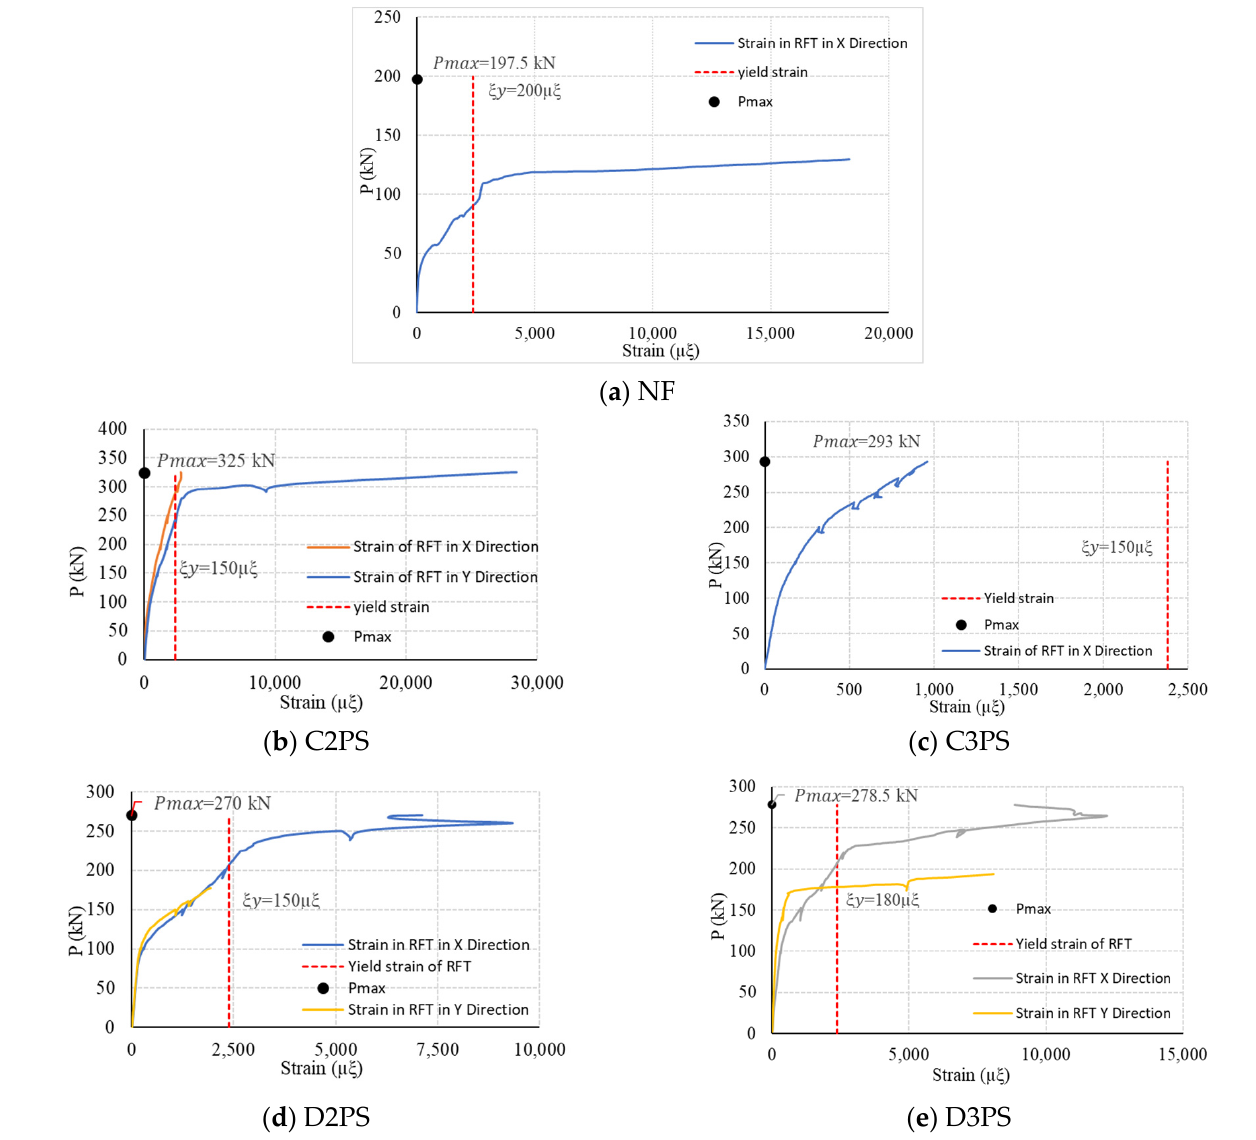
Figure 8. Load – strain response of steel reinforcement.